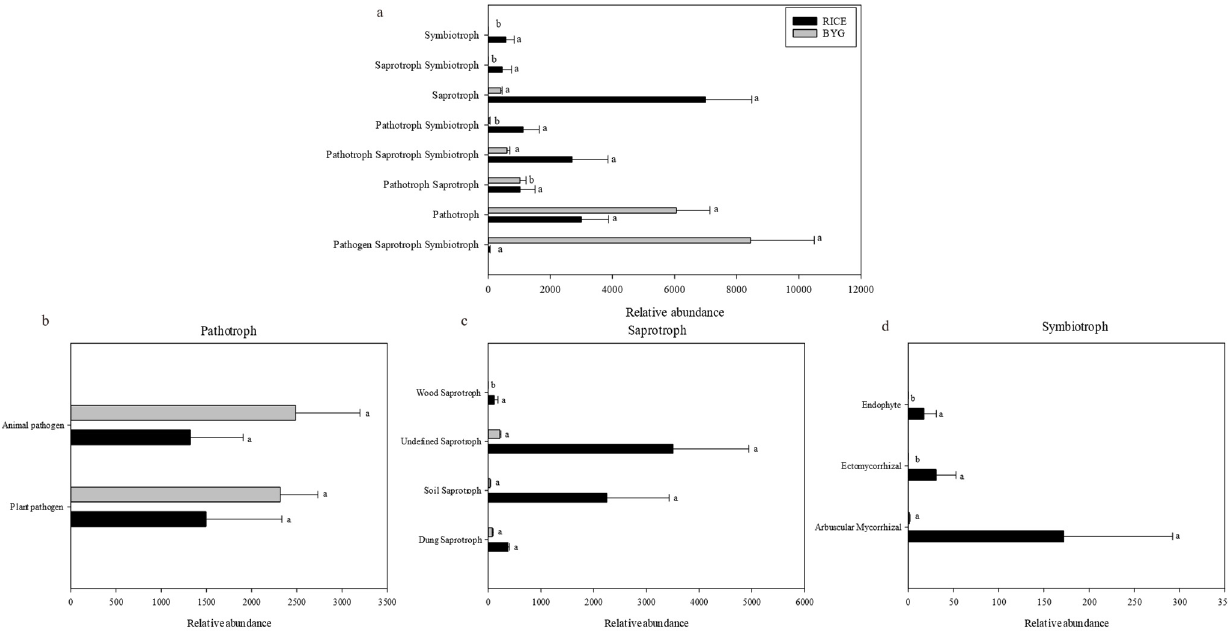
Figure 7. The relative abundance of trophic modes ( a ) and Guilds ( b – d ) assigned by FUNGuild for fungal communities. Different letters indicate significant difference between treatments detected by Tukey’s multiple test ( p < 0.05)